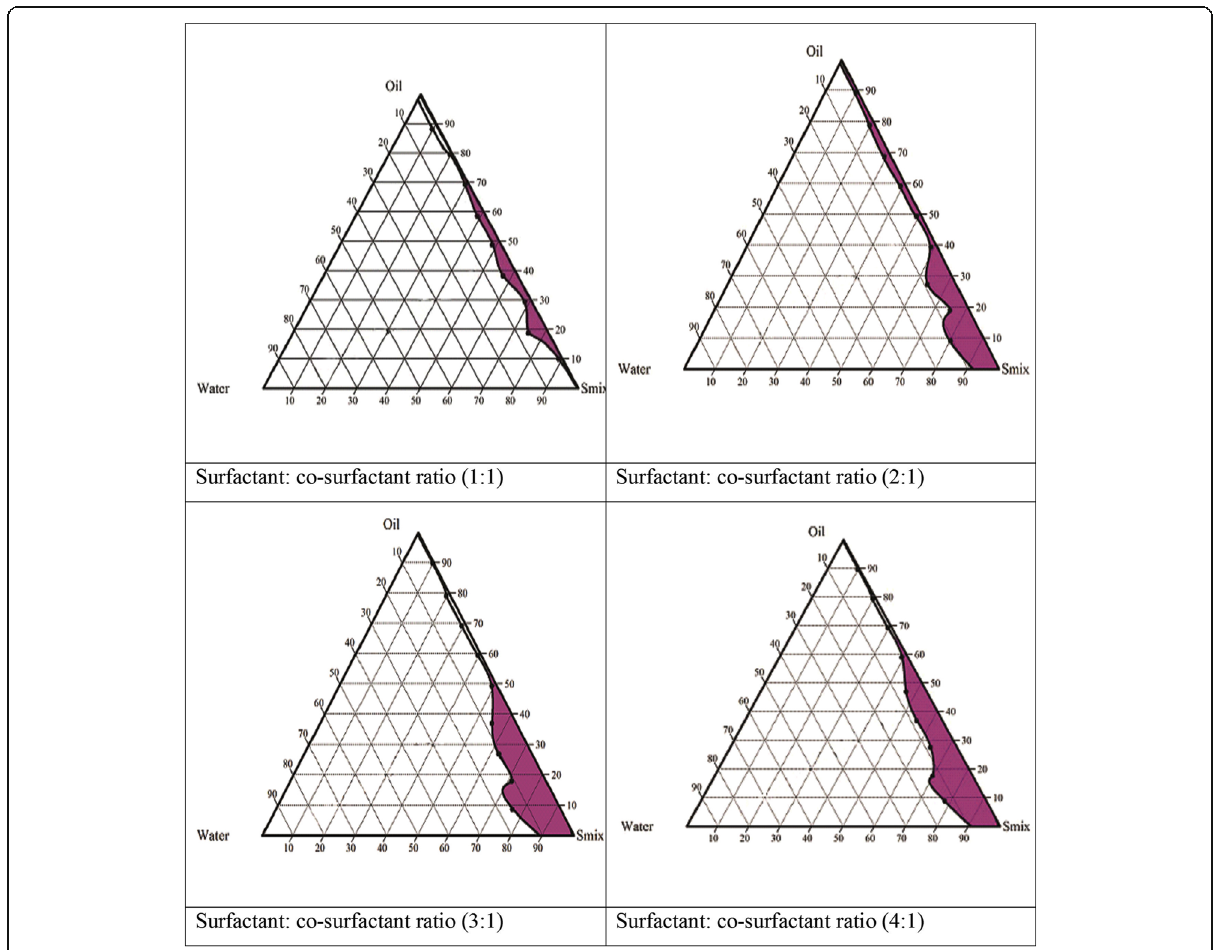
Fig. 2 The pseudo ternary phase diagrams of the oil-surfactant-water system at 1:1, 2:1, 3:1, and 4:1 weight ratio